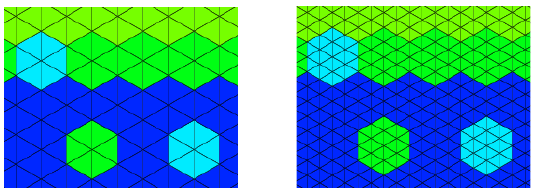
Figure 2. Mesh refinement in radial direction by subdividing each prism into sub prisms, shown here for hexagonal geometry. Different colors indicate different materials/cross section